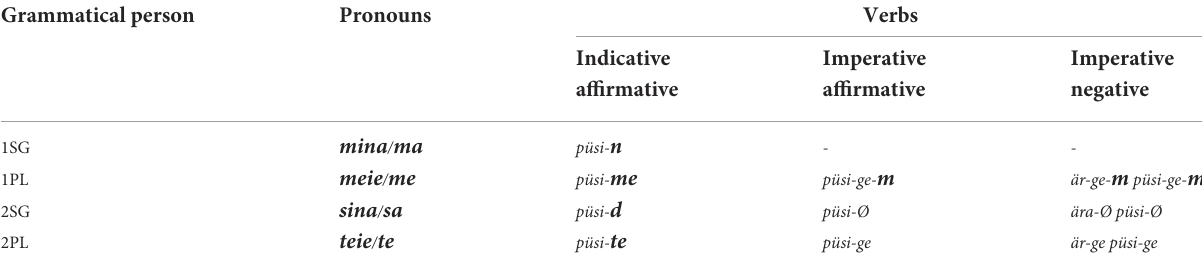
TABLE 1 The grammatical person forms of Estonian personal pronouns and verbs taken into account in the present study (in the imperative mood, only 1PL has the person marker; marker - ge - in 1PL and 2PL forms after the stem püsi - of the example verb püsima “to stay” indicates imperative